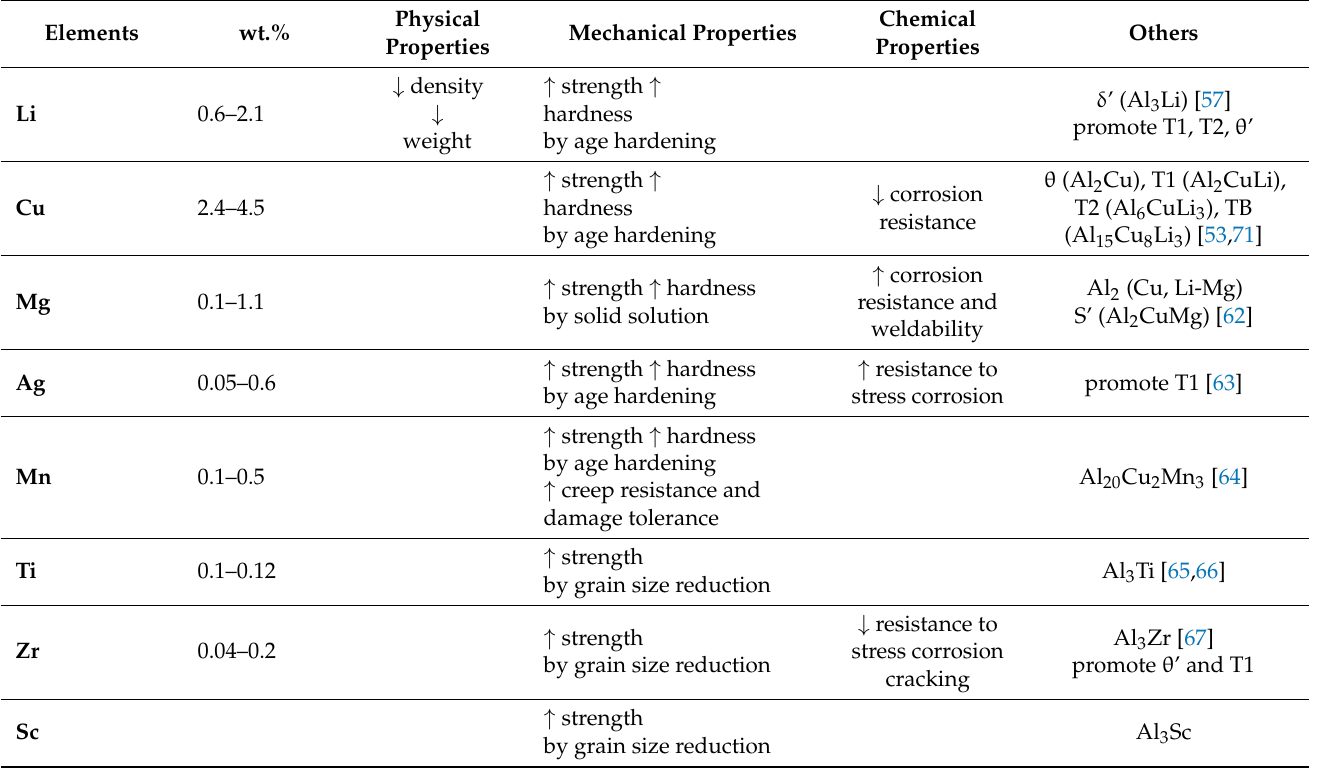
Table 1. Effects of alloying